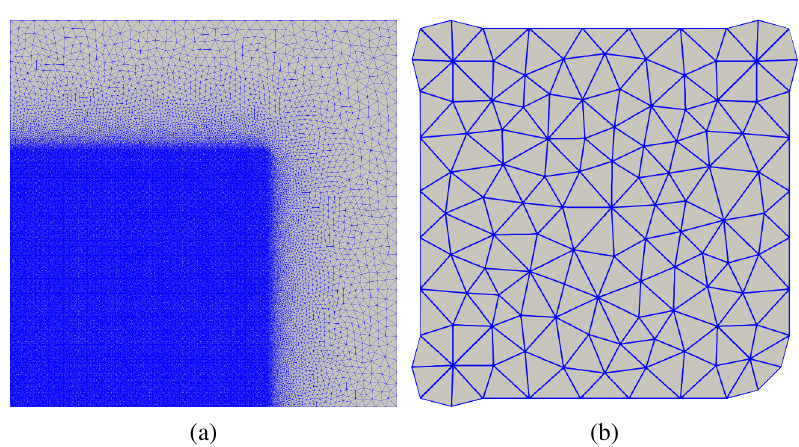
Figure 1: (a) Full mesh showcasing our varying element size from fuel assemblies to the moderator. (b) Unstructured mesh region near a fuel pin.